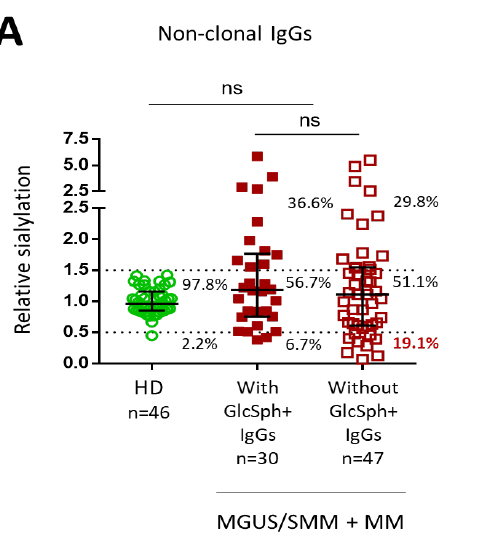
Figure 4. Level of sialylation of IgGs from MGUS / SMM and MM patients. Sialylation studies were performed using an ELLA (Enzyme Linked Lectin Assay) for IgG sialylation detection, as well as an ELISA (Enzyme Linked Immuno Sorbent Assay) for total IgG detection [15]. Clonal and non-clonal IgG fractions were prepared as described in Methods and published [15]. The relative sialylation of IgGs was expressed as the sialic acid / IgG optic density (OD) ratio. ( A ) Degree of sialylation of polyclonal IgGs from 43 healthy donors (HD) (OD ratio between 0.5 and 1.5) and of non-clonal IgGs from 77 patients. ( B ) Degree of sialylation of 91 purified monoclonal IgGs analyzed according to the target of the monoclonal IgG. Bars indicate means ± SEM. The percentages indicate the % of IgGs with a low (OD ratio < 0.5), normal (OD ratio: 0.5–1.5) or high (OD ratio > 0.5) degree of sialylation. Statistical analysis was performed using one-way ANOVA test followed by Tukey’s multiple comparison test. * p < 0.05, ** p < 0.01, *** p < 0.001. NS: not